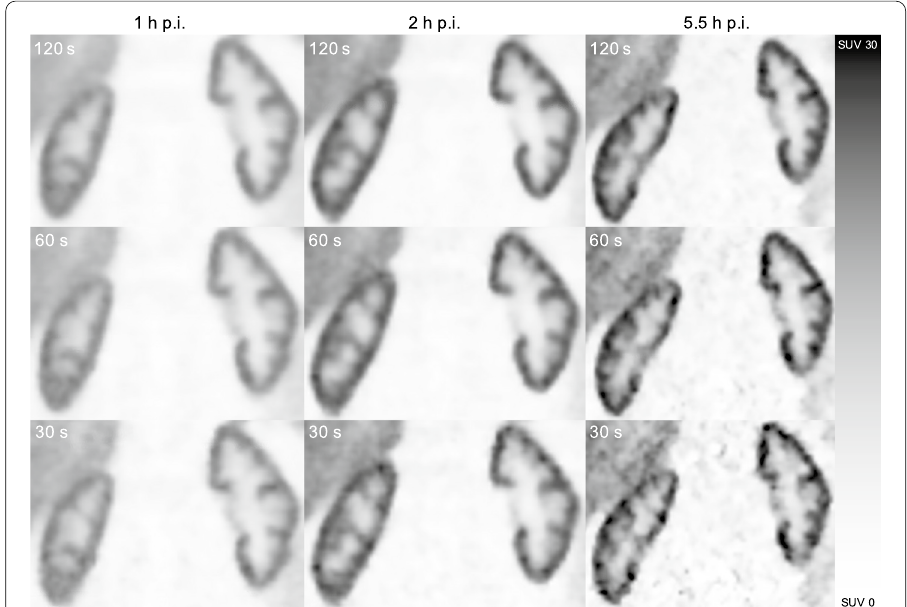
Fig. 3 Coronary images of the kidneys in a representative patient showing image quality at different acquisition durations per bp (rows) and time points after injection (columns). bp: bed position, p.i.: